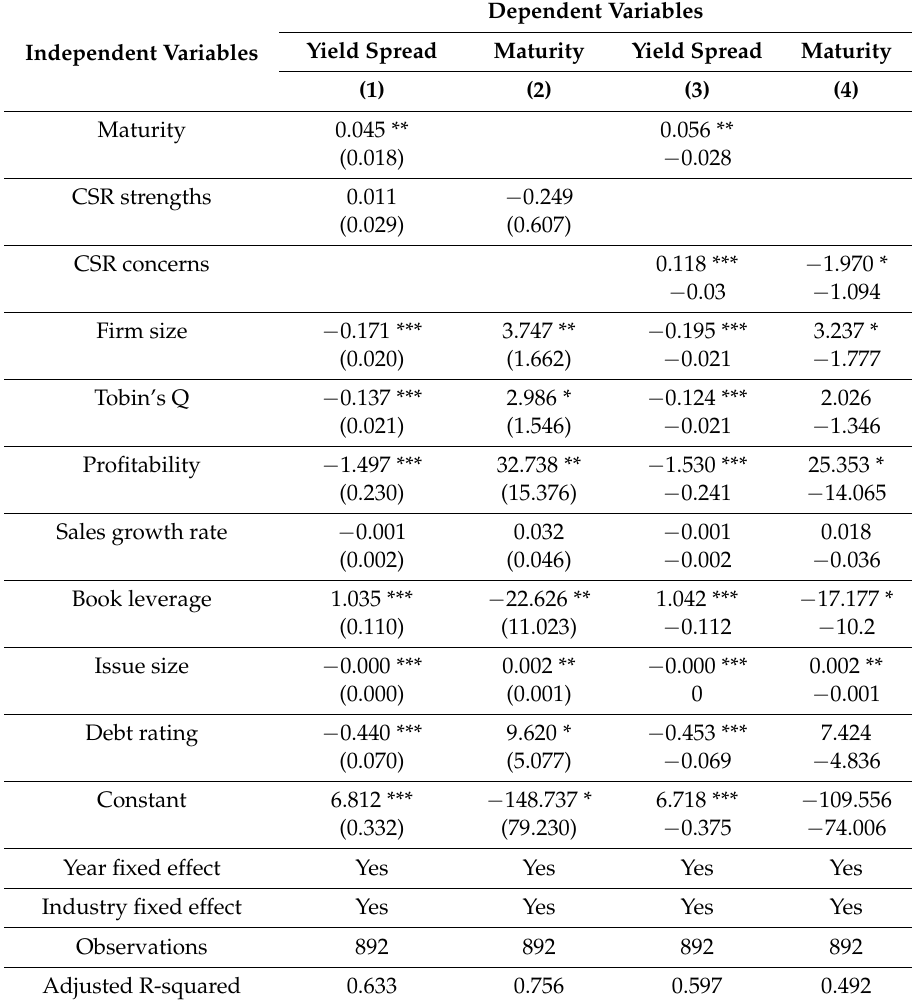
Table 5. Simultaneous determination of bond yield spread and maturity: three-stage least squares (3SLS)